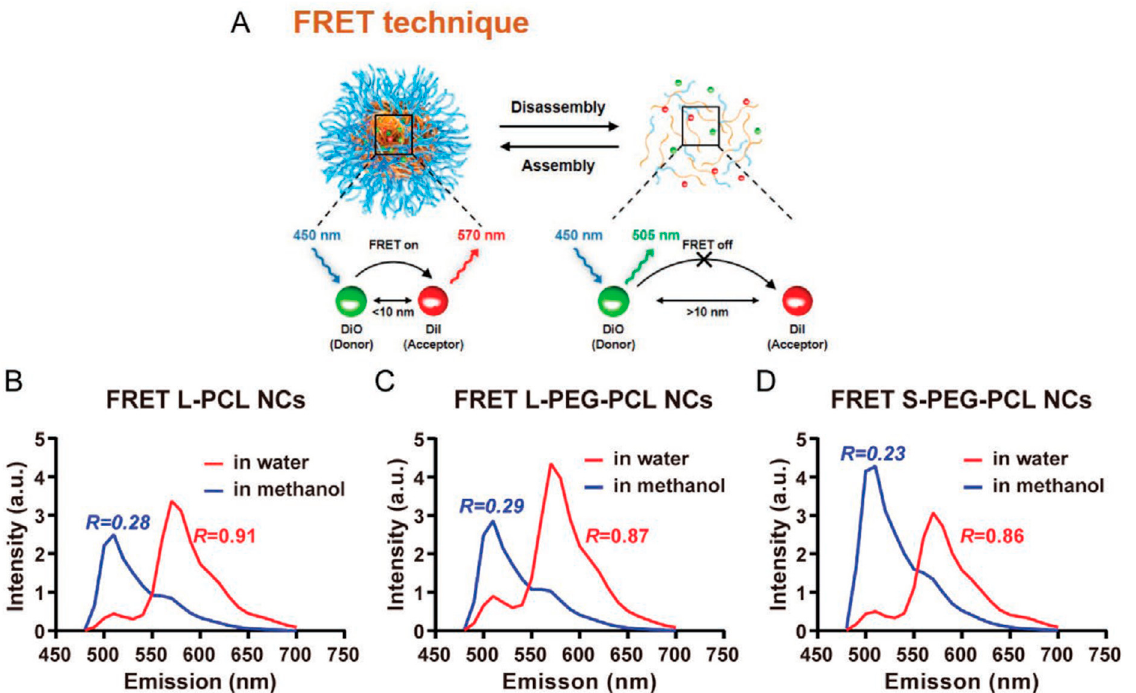
Figure 7. FRET for studying in vitro and ex vivo stability of polymeric NCs. ( A ) Schematic of the FRET principle (“FRET on”) and disappearance (“FRET off”). ( B – D ) Fluorescence spectra and FRET ratio of large PCL NCs ( B ), large PEG-PCL NCs ( C ), and small PEG-PCL NCs ( D ) in water (red) and methanol (blue). Reproduced with permission from ref. [58]. Copyright 2021, Wiley-VCH GmbH.